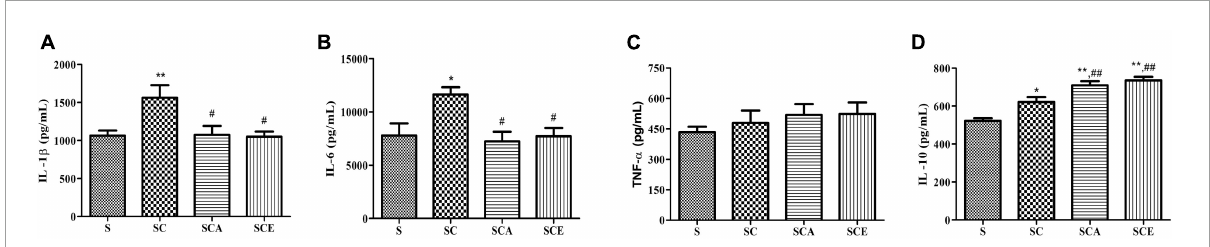
FIGURE4 Effects of atorvastatin and ezetimibe treatment on the levels of lung pro-inflammatory and anti-inflammatory cytokines in high-cholesterol fed rats. (A) Tumor necrosis factor-alpha (TNF- α ); (B) interleukin-6 (IL-6); (C) interleukin-1 beta (IL-1 β ); (D) interleukin-10. Each bar represents mean ± SEM. * p < 0.05; ** p < 0.01 vs. the control group; # p < 0.05; ## p < 0.01 vs. the SC group ( n = 6 per group).